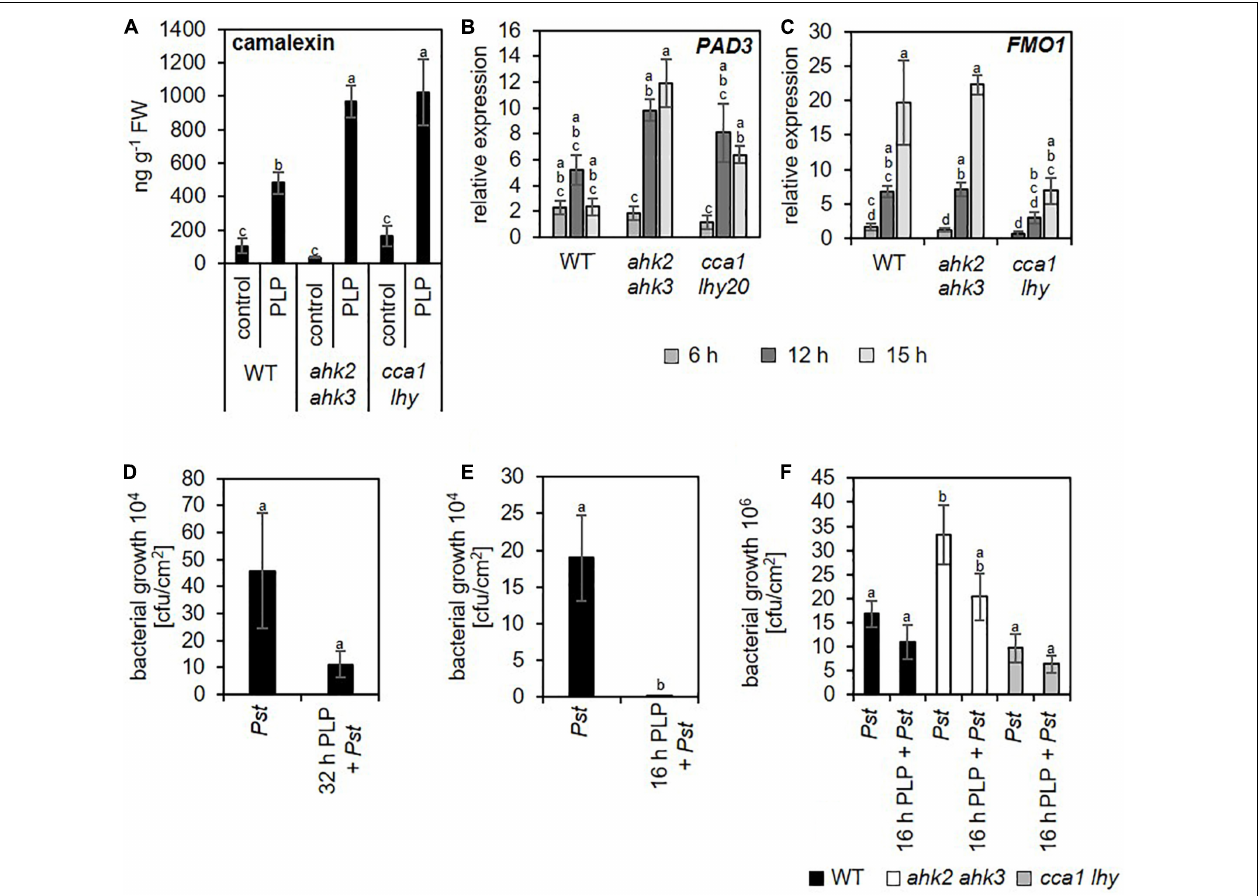
FIGURE 8 | Photoperiod stress activates the plant pathogen response improving resistance against Pseudomonas infection. Five-week-old short-day (SD)-grown plants (WT, ahk2 ahk3 and cca1 lhy) were exposed to a prolonged light period (PLP) of 32 h followed by a normal SD night. (A) Camalexin concentration at 15 h after photoperiod stress treatment. Error bars represent SE ( n = 8). (B,C) Relative expression of PAD3 (B) and FMO1 (C) in WT, ahk2 ahk3 and cca1 lhy plants during the night following the 32 h PLP measured by qRT-PCR. Only results for PLP-treatment are presented. All values are expressed relative to 0 h WT control which was set to 1. Error bars represent SE ( n ≥ 3). (D,E) Bacterial growth in Arabidopsis WT plants pretreated with a 32 h (D) or 8 h (E) PLP. (F) Bacterial growth in photoperiod stress-sensitive mutants pretreated with 16 h PLP. Bacterial infection with Pseudomonas syringae pv. tomato DC3000 (inoculum OD 600 = 0.002) occurred during the day following the PLP and bacteria were extracted from leaves 3 days later. Error bars represent SE ( n = 8). Letters indicate different statistical groups ( p ≤ 0.05) as determined by a Welch t -test (D,E) or an ANOVA followed by Tukey’s post-hoc test (A–C,F)